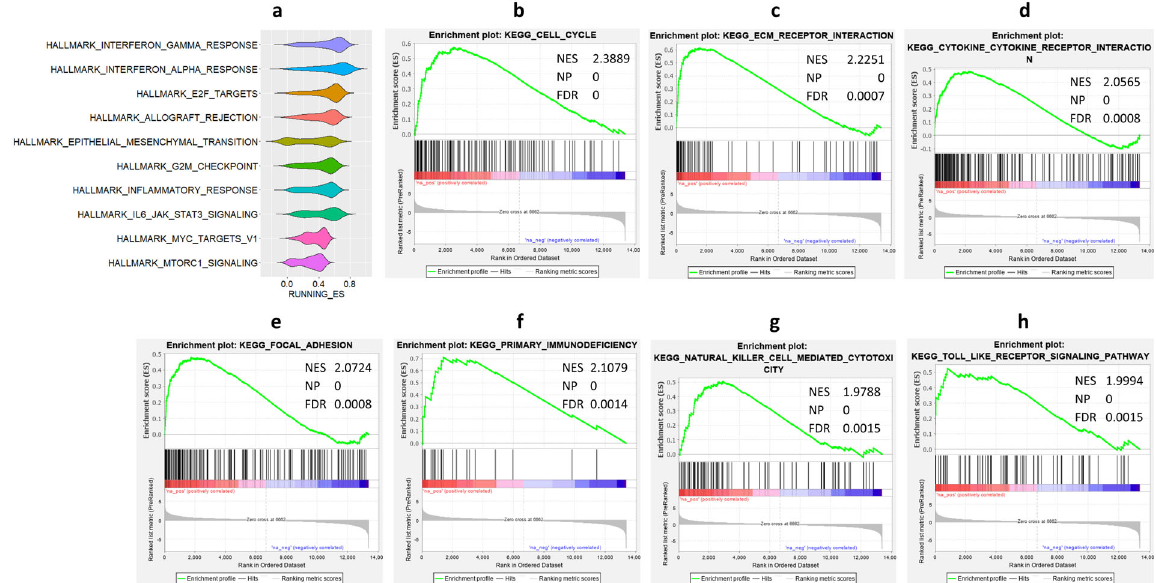
Fig. 4 Signi fi cant enrichment of Hallmark gene sets and KEGG pathways in OSCC-GB tumor samples using GSEA. a Violin plot showing the distribution of enrichment scores (ES) of all ranked genes that belong to the 10 most signi fi cantly enriched Hallmark gene sets. b – h Enrichment plots of 7 of the 10 most signi fi cantly enriched KEGG pathways. These include b cell cycle, c ECM receptor interaction, d cytokine − cytokine receptor interaction, e focal adhesion, f primary immunode fi ciency, g natural killer cell-mediated cytotoxicity, and h Toll-like receptor signaling